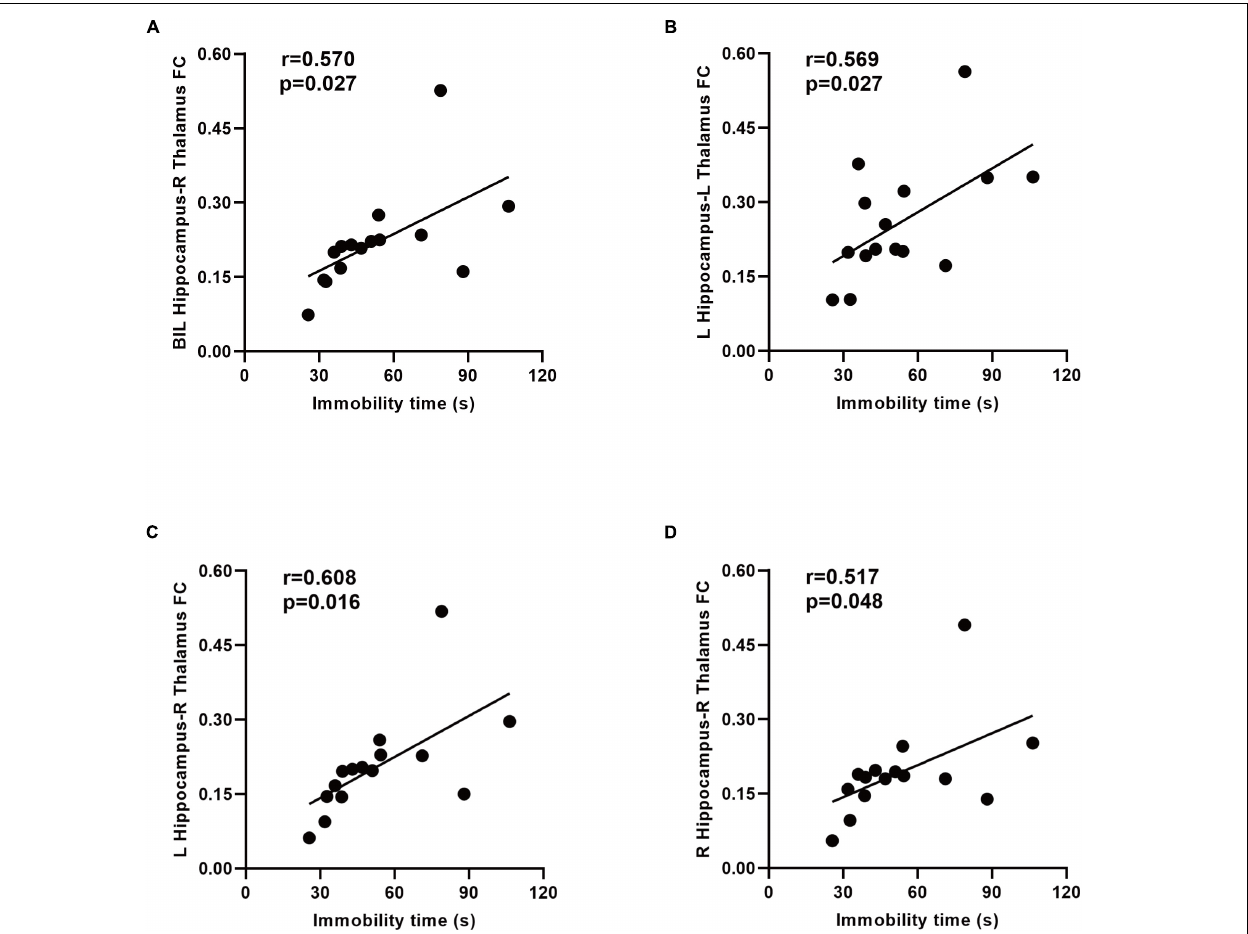
FIGURE 6 | Relationship between the immobility time and functional connectivity (FC) in the SAE group. A positive correlation between the immobility time and zFC values between the bilateral hippocampus and right thalamus was found (A) . There was a positive correlation between the immobility time and zFC values between the left hippocampus and thalamus (B,C) . Increased connectivity between the right hippocampus and right thalamus associated with the immobility time in the forced swimming test (D) . BIL, bilateral; L, left; R, right; FC, functional